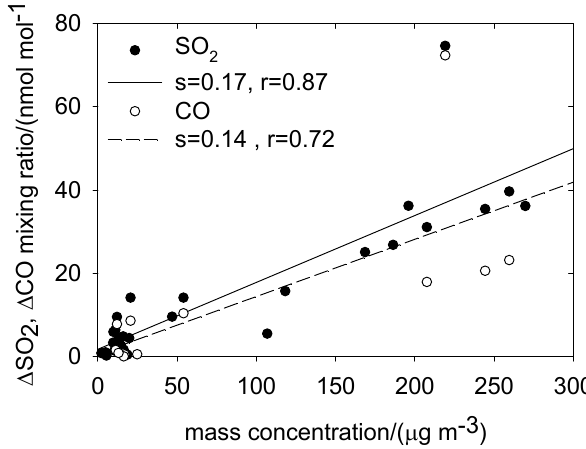
Fig. 25. Single scattering albedo ω 0 and asymmetry parameter g for 532nm wavelength versus effective diameter D eff . Note, the T- matrix computations for case L are performed for an imaginary part of the refractive index of 0.001. The lines represent least squares fits to the ω 0 data versus D eff (inµm), with correlation coefficients r as given.